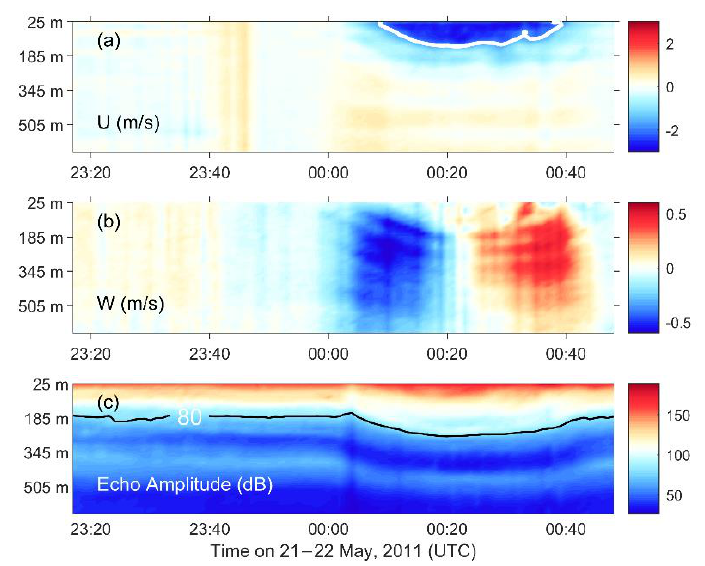
Figure 3. Current velocity and echo amplitude profiles of the ISW. ( a ) Zonal current velocity. The thick white line indicates the phase speed of ISW estimated from Korteweg-De Vries (KdV) theory. ( b ) Vertical current velocity. ( c ) Echo amplitude; the 80 dB isopycnal is highlighted by the black lines.